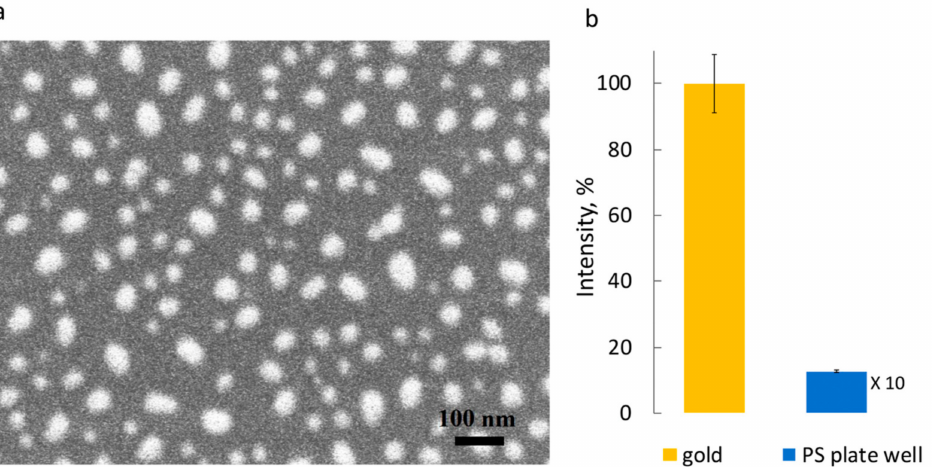
Figure 5. ( a ) SEM image of the plasmon-active surface—Au nanostructured discontinious film on the SiO 2 chip surface (the task of the time-resolved cortisol monitoring relies on the plasmon